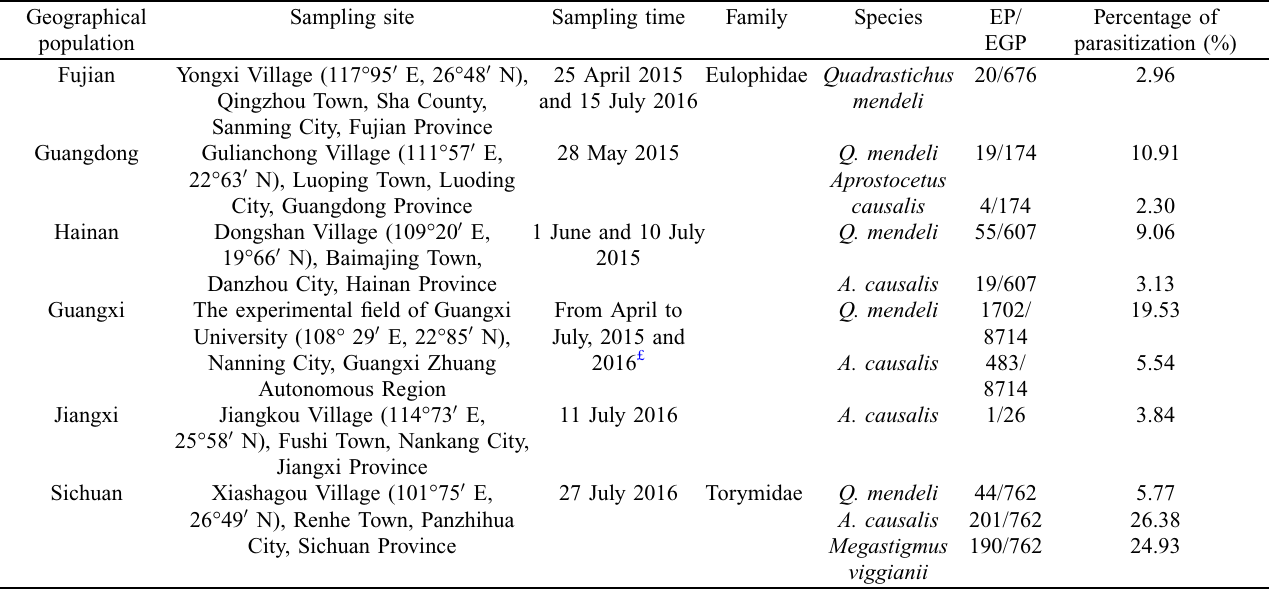
Table 1. Percentages of parasitization by parasitoids in Leptocybe invasa . Geographical Sampling site Sampling time population